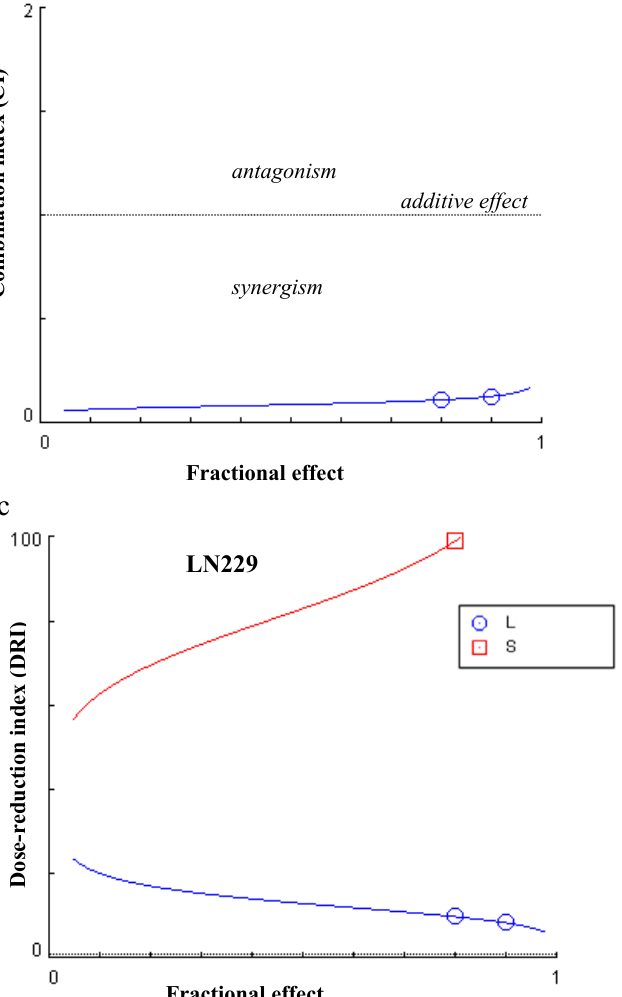
Figure A3. Lensoside A β (L) and sorafenib (S) combination treatment. ( a ) Combination index (CI) plot: The combination index is plotted as a function of Fa (fractional effect). ( b ) Isobologram for combination: isobologram at IC50, IC75, and IC90. ( c ) the F a -DRI (dose reduction index) plot (Chou-Martin plot). Combination index (CI) and dose reduction index (DRI) were calculated according to the method of Chou and Talalay using the Compusyn software. CI < 1, CI = 1 and CI > 1 indicate synergistic effect, additive effect, and antagonistic effect, respectively. The combination of lensoside A β with sorafenib in the LN229 line showed a synergistic effect. For the experimentally determined dose (1 µM of sorafenib and 50 µM of lensoside A β ), the CI and Fa were 0.12 and 0.9 respectively. That means, the concentrations of used compounds, induced programmed death in 90% of cells.